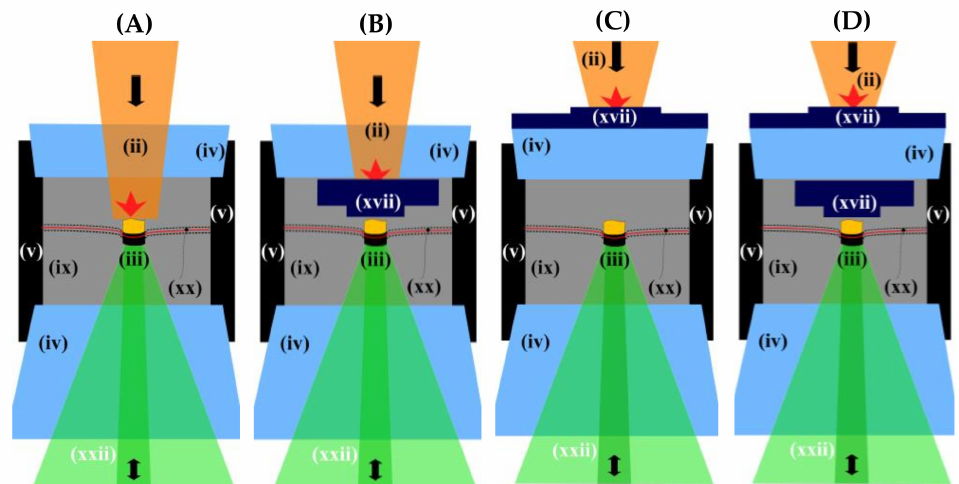
Figure 2. Illustrations of laser-driven dynamic compression diamond anvil cell (LDC–DAC) exper- iments. ( A ) The sample of interest is the target, ( B ) a separate target inside the anvil, ( C ) a target outside the anvil, and ( D ), a target outside and driver inside the anvil. Please see article text for component